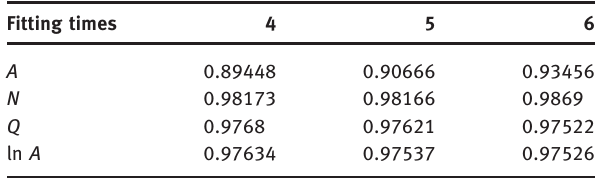
Table 1: Regression fitting coefficients of constants α , n , Q , and ln A . Fitting times